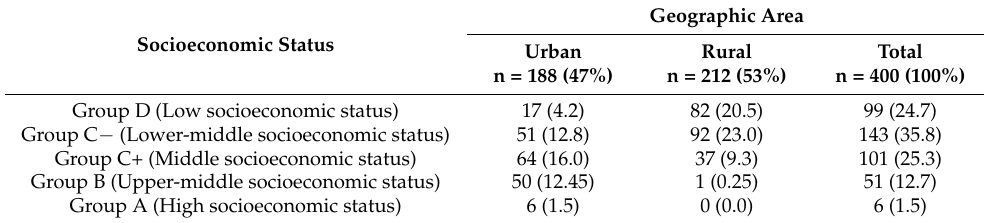
Table 1. Older adults by socioeconomic status and geographic